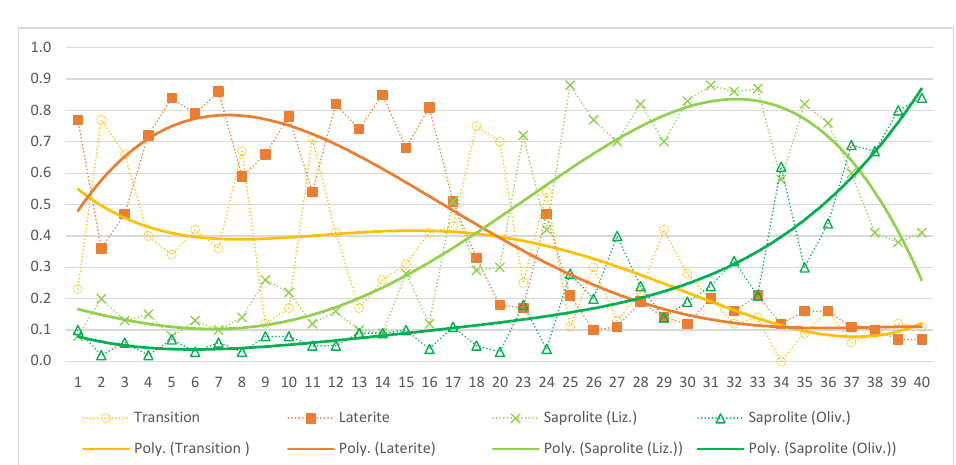
Figure 7. Plot of membership coefficients and trendlines of all clusters against sample number, colors represent the different cluster as identified in Figures 5 and 6 and Table 1.